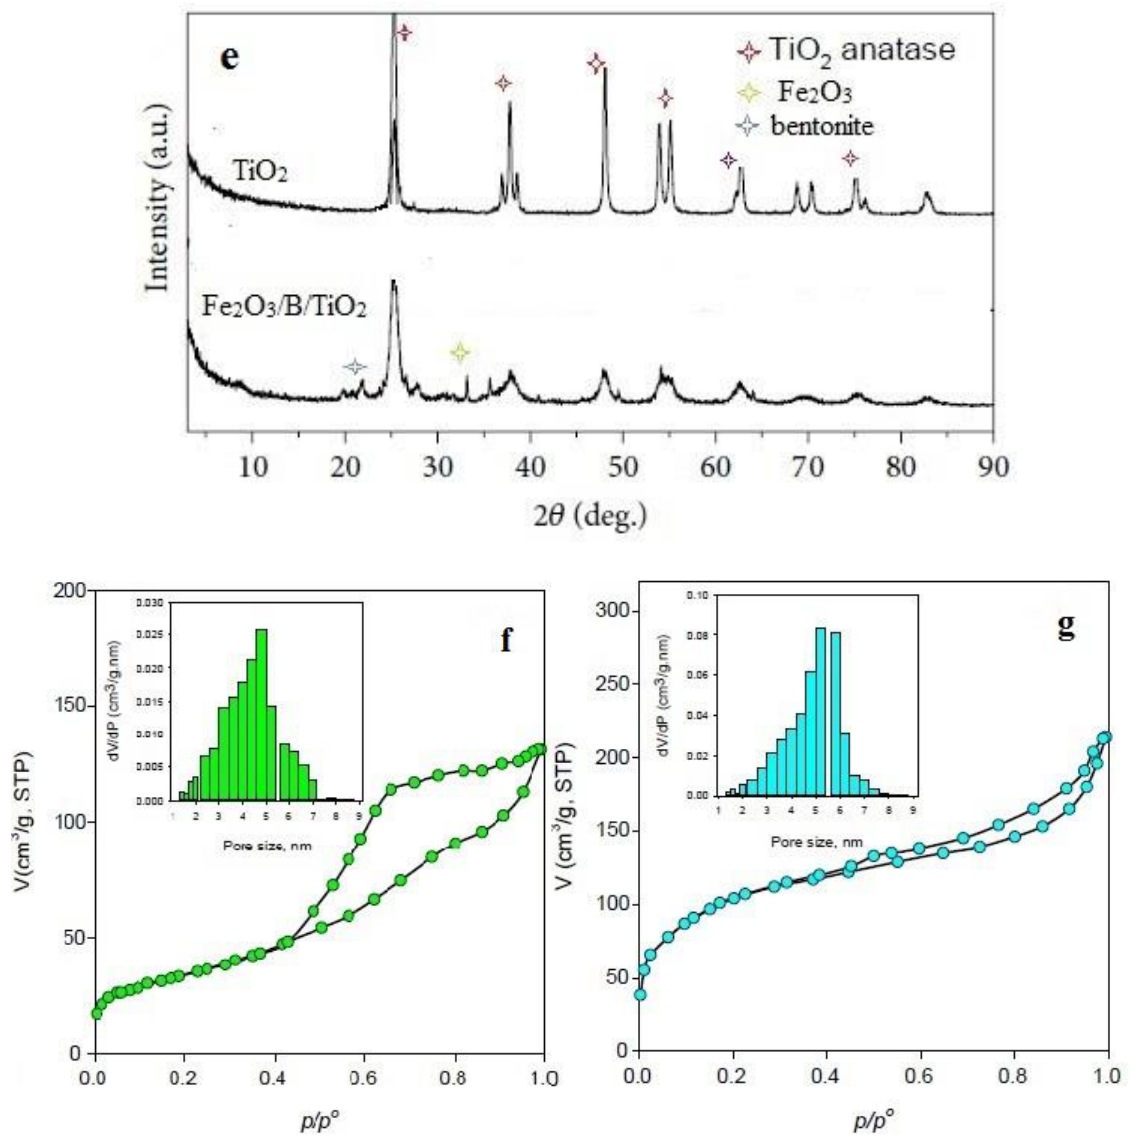
Figure 2. SEM images of bentonite ( a ), SEM images of Fe 2 O 3 /B/TiO 2 ( b ), TEM images of Fe 2 O 3 /TiO 2 and Fe 2 O 3 /B/TiO 2 ( c,d ), XRD patterns of Fe 2 O 3 /B/TiO 2 ( e ), N 2 adsorption-desorption isotherms Inset: distributions of pore size from the adsorption branches using the BJH method N 2 adsorption-desorption isotherm ( f – g ).